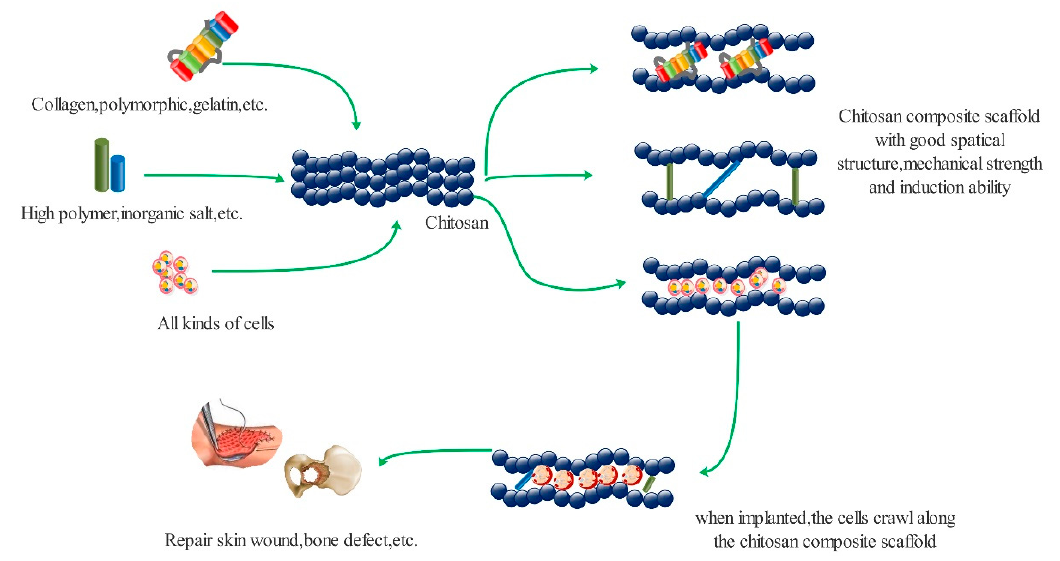
Figure 6. Chitosan promotes different tissue defect repair mechanisms by carrying other macromolecules.